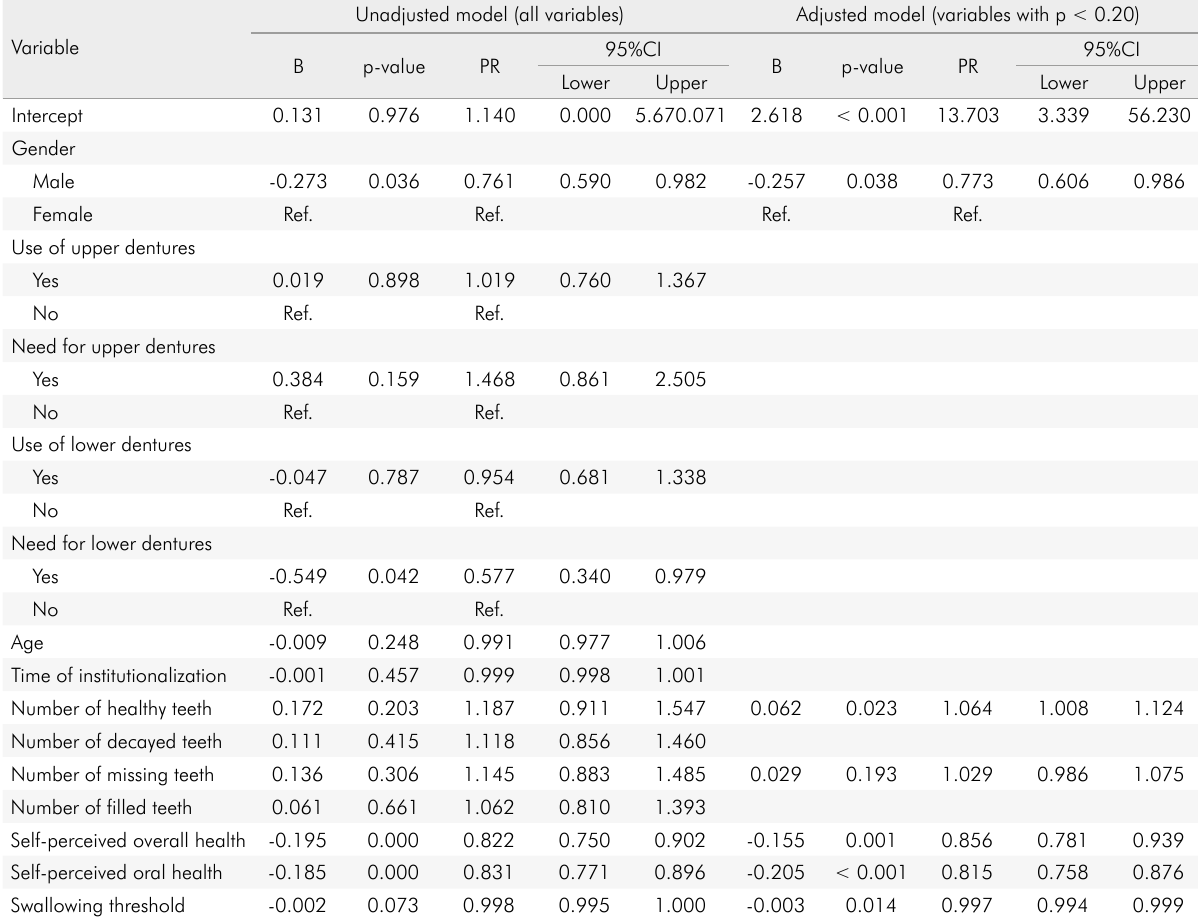
Table 3. Unadjusted and adjusted models of Poisson multivariate regression to investigate the factors associated with OHRQoL (measured by OHIP-14 questionnaire) among institutionalized elderly individuals in the cities of João Pessoa and Piracicaba, Brazil (2019). Variable